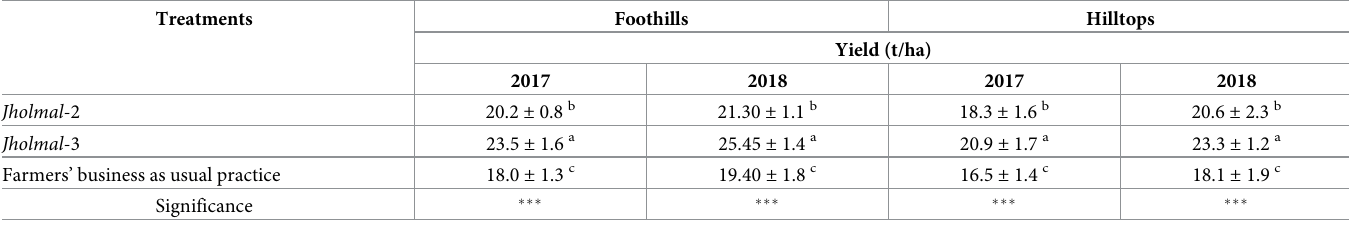
Table 3. Effect of different treatments on bitter gourd yield at Kavre,